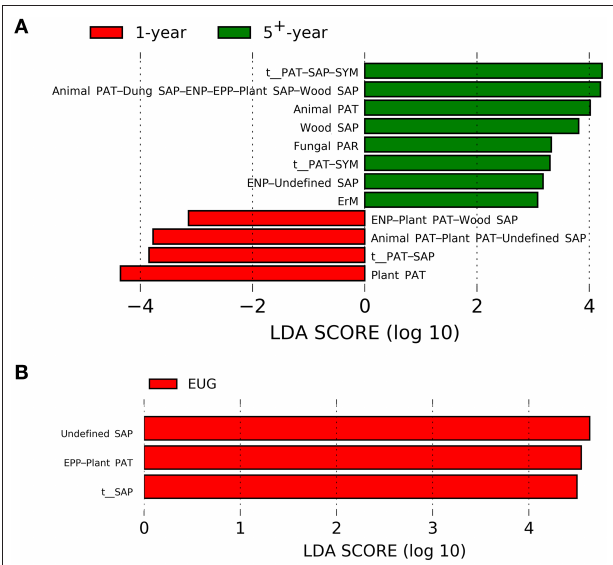
FIGURE 4 | Fungal functional guilds significantly differentiated in Eucalyptus plantations with different (A) ages and (B) species identified by linear discriminant analysis coupled with effect size (LEfSe) using parameters of a threshold of LDA score > 3 and p < 0.05. EUG, E. urophylla × E. grandis ; PAT, pathotroph; PAR, parasite; SAP, saprotroph; SYM, symbiotroph; ENP, endophyte; EPP, epiphyte; ErM, ericoid